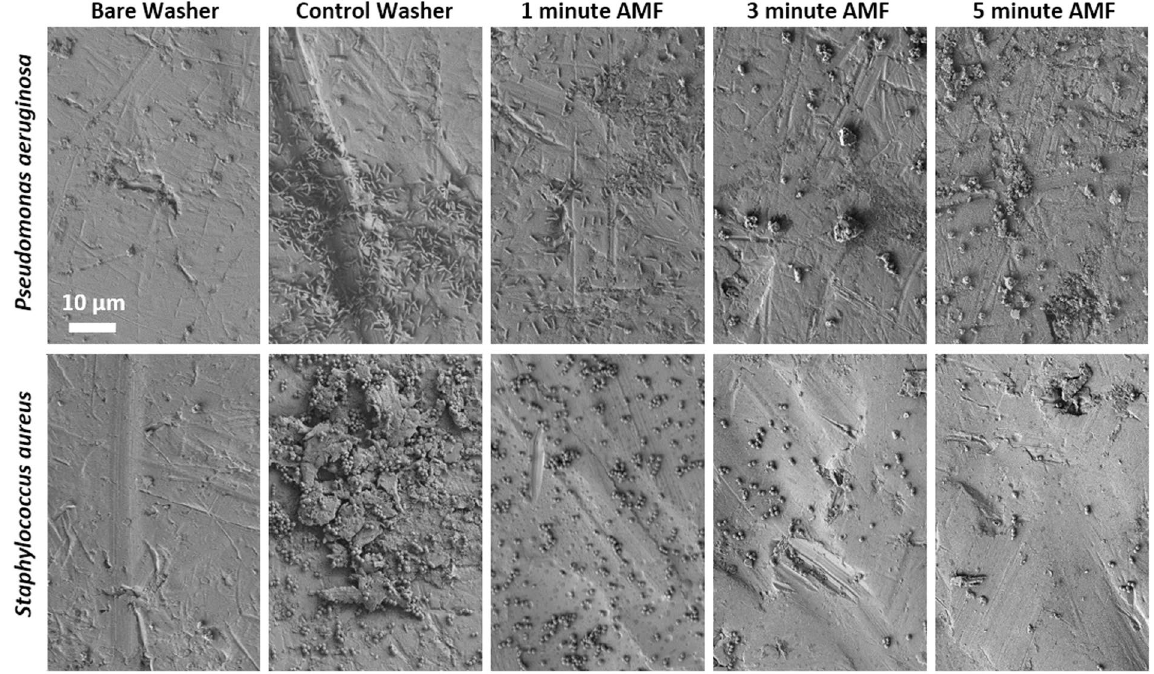
Figure 4. Scanning electron microscopy reveals that AMF exposures remove both EPS and bacteria found within biofilm. The two rows show the results for different bacteria (top – PA01, bottom – JE2) and the columns show images acquired for washers exposed to different durations of AMF. A negative control (washer with no bacteria) is shown in the left most column, and a positive control (washer with biofilm but no AMF exposure) is shown in the second column. The EPS appears to be removed after 1 minute of AMF exposure, although bacteria are still visible on the washer surface. For exposures greater than 3 minutes, it was difficult to find any bacteria on the washers, and only scattered aggregates of material were visible on the washer